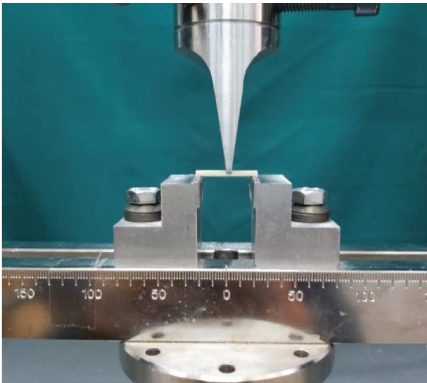
Figure 2: Universal testing machine.